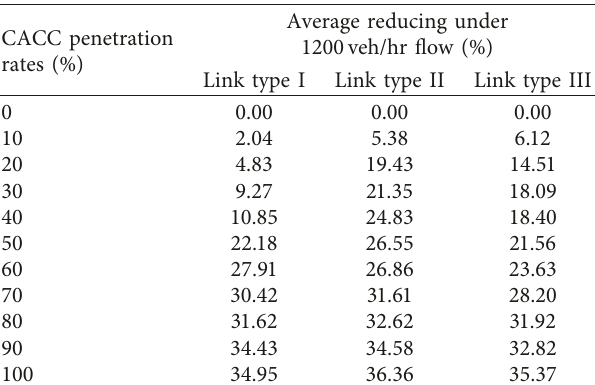
Table 2: Percentage reductions of CI under 1200veh/hr flow. CACC